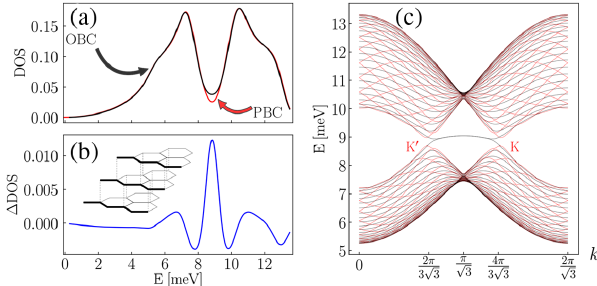
FIG. 7. (a) Calculated magnon density of states (DOS) for open boundary conditions (OBC, black) and periodic boundary con- ditions (PBC, red). The open boundary terminates on a surface with a zigzag edge. The DOS in both cases exhibits a V-shaped wedge arising from the bulk Dirac nodal lines. For OBC, the DOS is a sum of the surface and bulk magnon contributions. (b) The excess DOS, denoted Δ DOS, corresponds to the difference DOS (OBC)-DOS(PBC), and it arises from surface magnons appearing at the Dirac line node energy. The geometry of the zigzag edge of an ABC stacked honeycomb lattice is shown in the inset. (c) Magnon spectra along a cut parallel to the zigzag edge, k Edge states can be seen connecting the bulk Dirac nodes at the Dirac energy E ≃ 8 . 5 meV. These states are responsible for the excess Δ DOS in panel (b). These surface magon states are not found for a surface along the armchair edge (see Supplemental Material